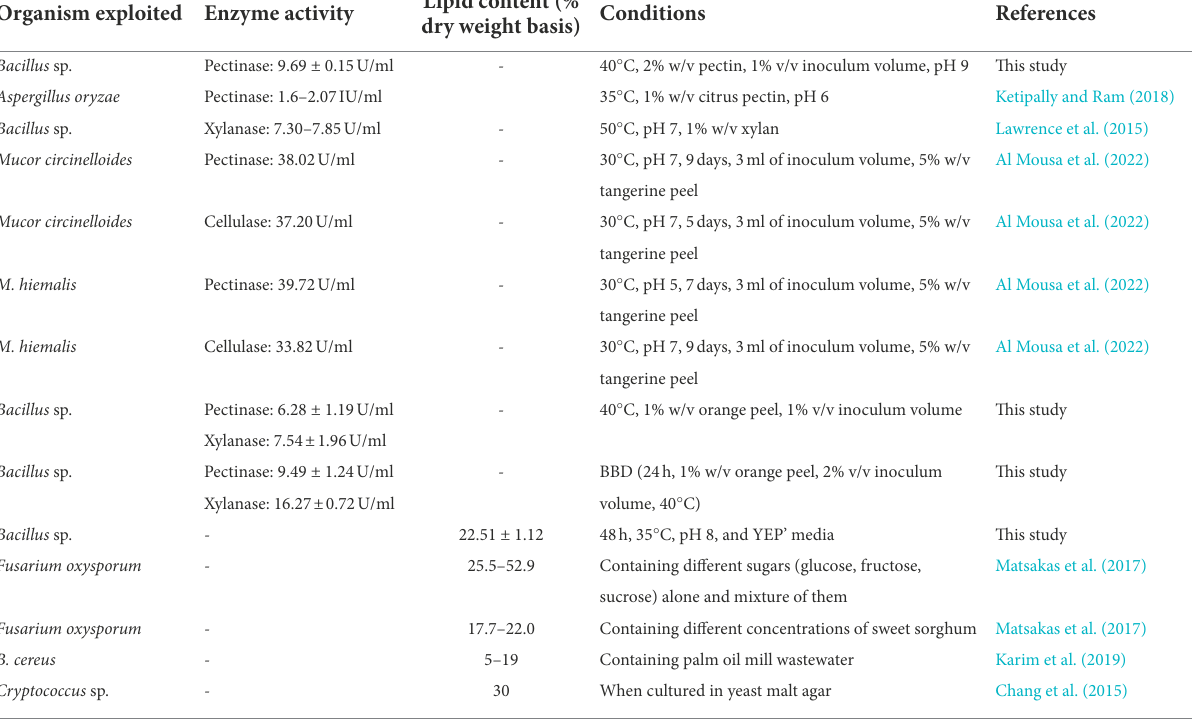
TABLE 4 Enzyme activity and lipid content exhibited by various organisms. Organism exploited Enzyme activity